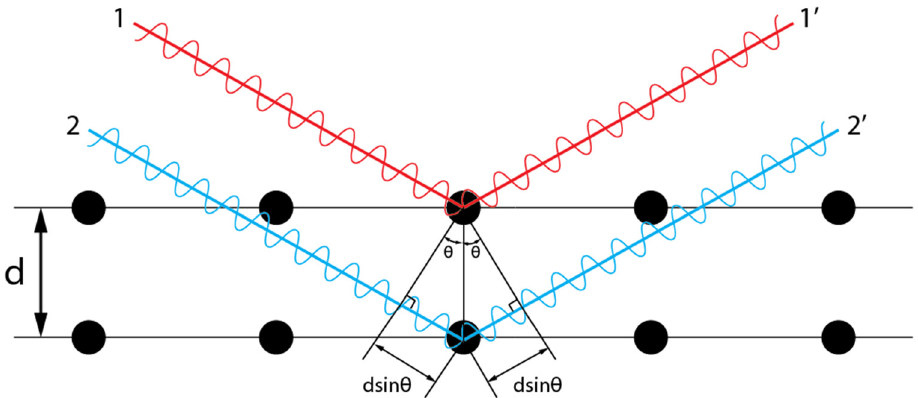
Figure 1. Diffraction of X-rays on two atomic